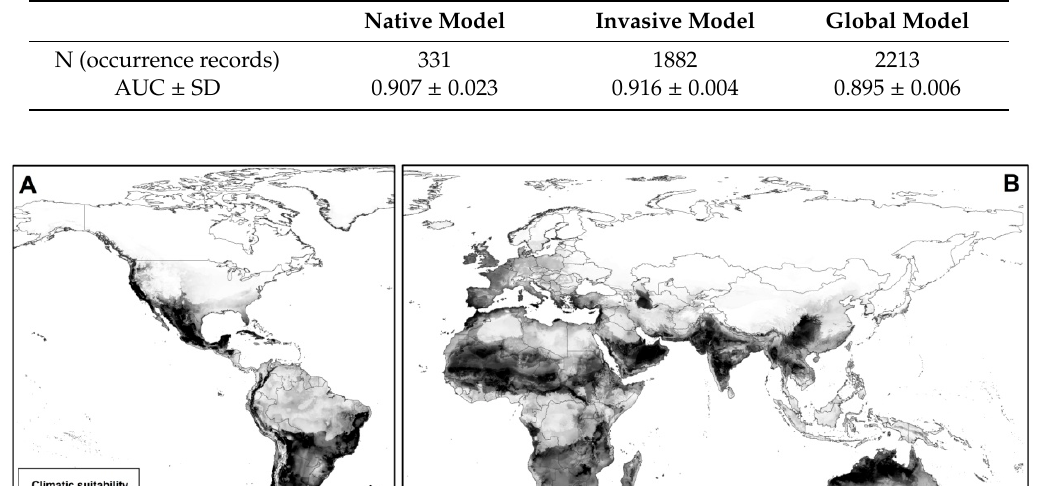
models and the AUC values and standard deviation for Azolla filiculoides models performance.